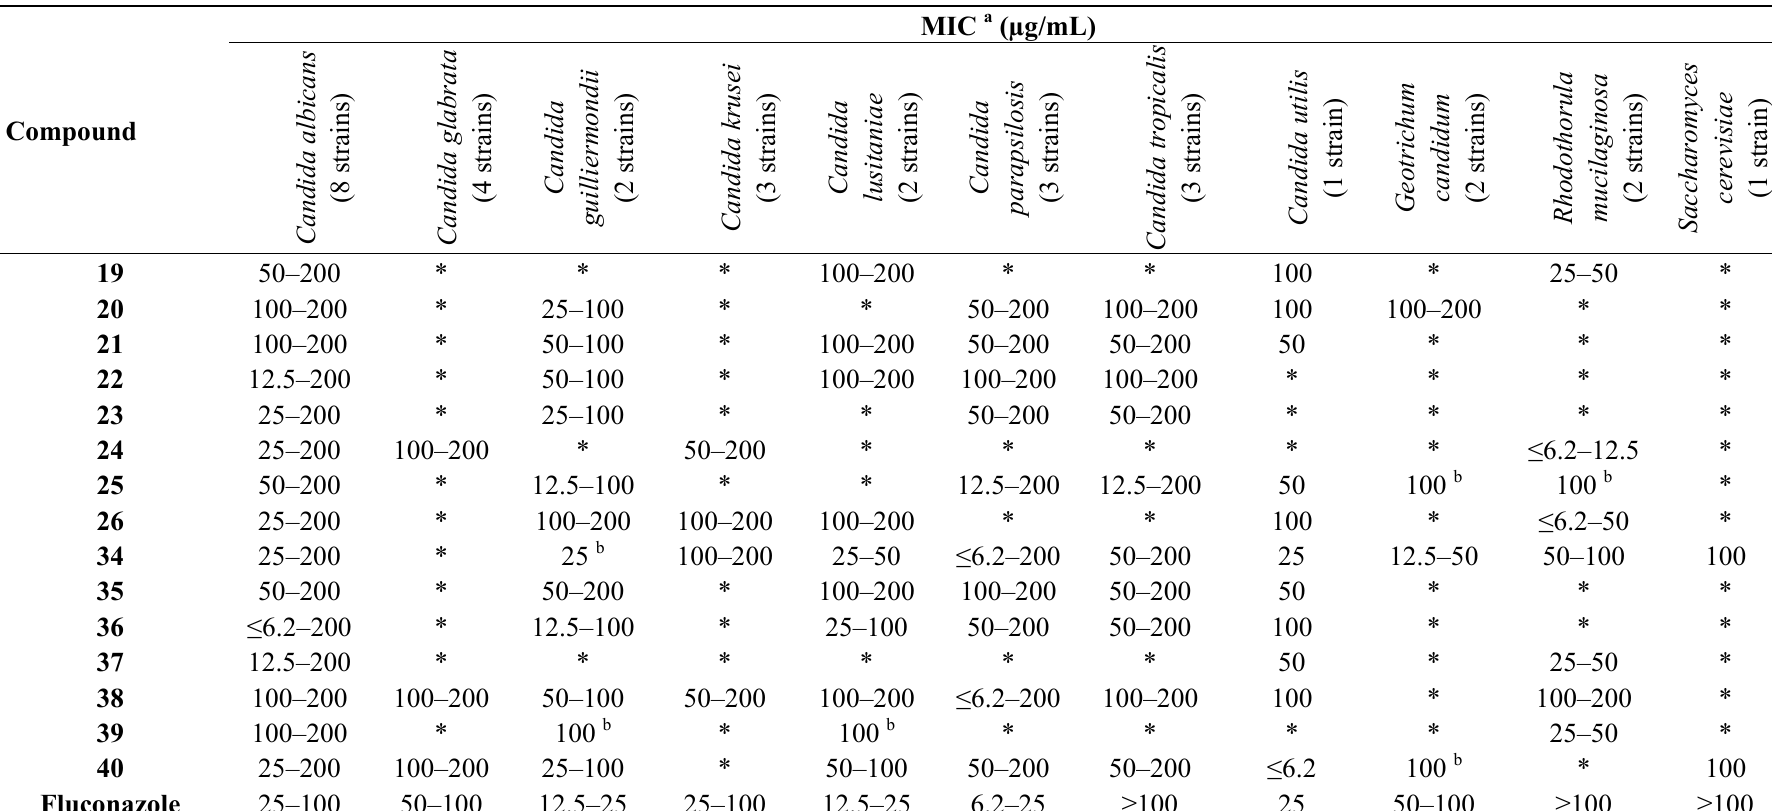
Table 1. The range of MICs obtained for the synthesized compounds 19 – 26 and 34 – 40 and fluconazole against strains isolated from